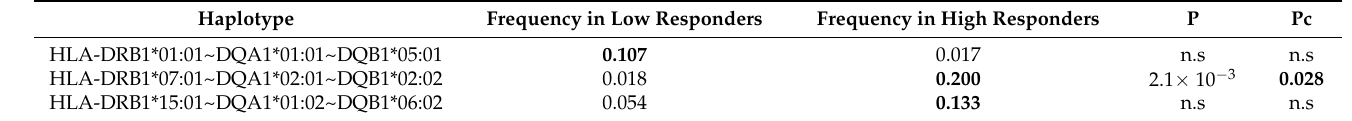
Table 3. Comparison of haplotype